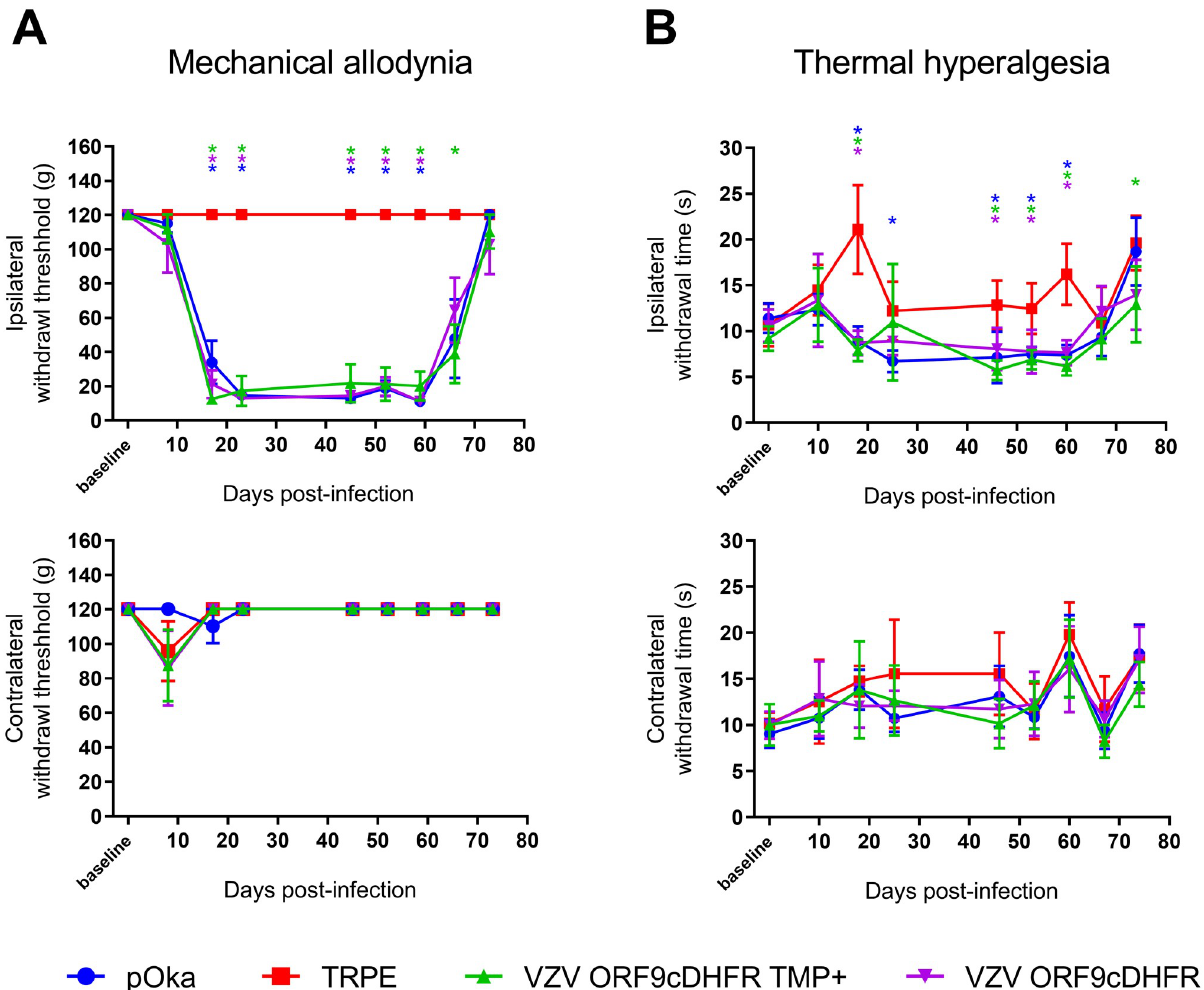
Fig 7. Development of mechanical and thermal hypersensitivity in rats after VZV ORF9cDHFR footpad inoculation under permissive and nonpermissive growth conditions. Male Sprague-Dawley rats (n = 6/group) were acclimated to measurement conditions and a baseline response was established the day of inoculation. Rats were inoculated in one rear footpad with 2x10 5 PFU TRPE-associated pOka (blue circle), VZV ORF9cDHFR in PBS with 500 nM TMP (green triangle) or without TMP (purple triangle), or uninfected TRPE cell equivalent (red square). Mechanical hypersensitivity (A) was measured by von Frey monofilaments and the Up-Down method. MA assessment of the inoculated footpad was measured as 50% withdrawal threshold in grams (g) in the inoculated footpad (top) and the contralateral, uninoculated footpad (bottom) of the same rats. Thermal hypersensitivity (B) was assessed by Hargreaves apparatus as detailed in the methods and is presented as time-to-withdrawal post-light activation (seconds). The responses of the inoculated footpad (top) and contralateral footpad of the same rats (bottom) is shown. Error bars: SD. Statistics: Two-way ANOVA with Bonferroni multiple comparison to uninfected cell control, where � = p < .05 and is color coded by group.